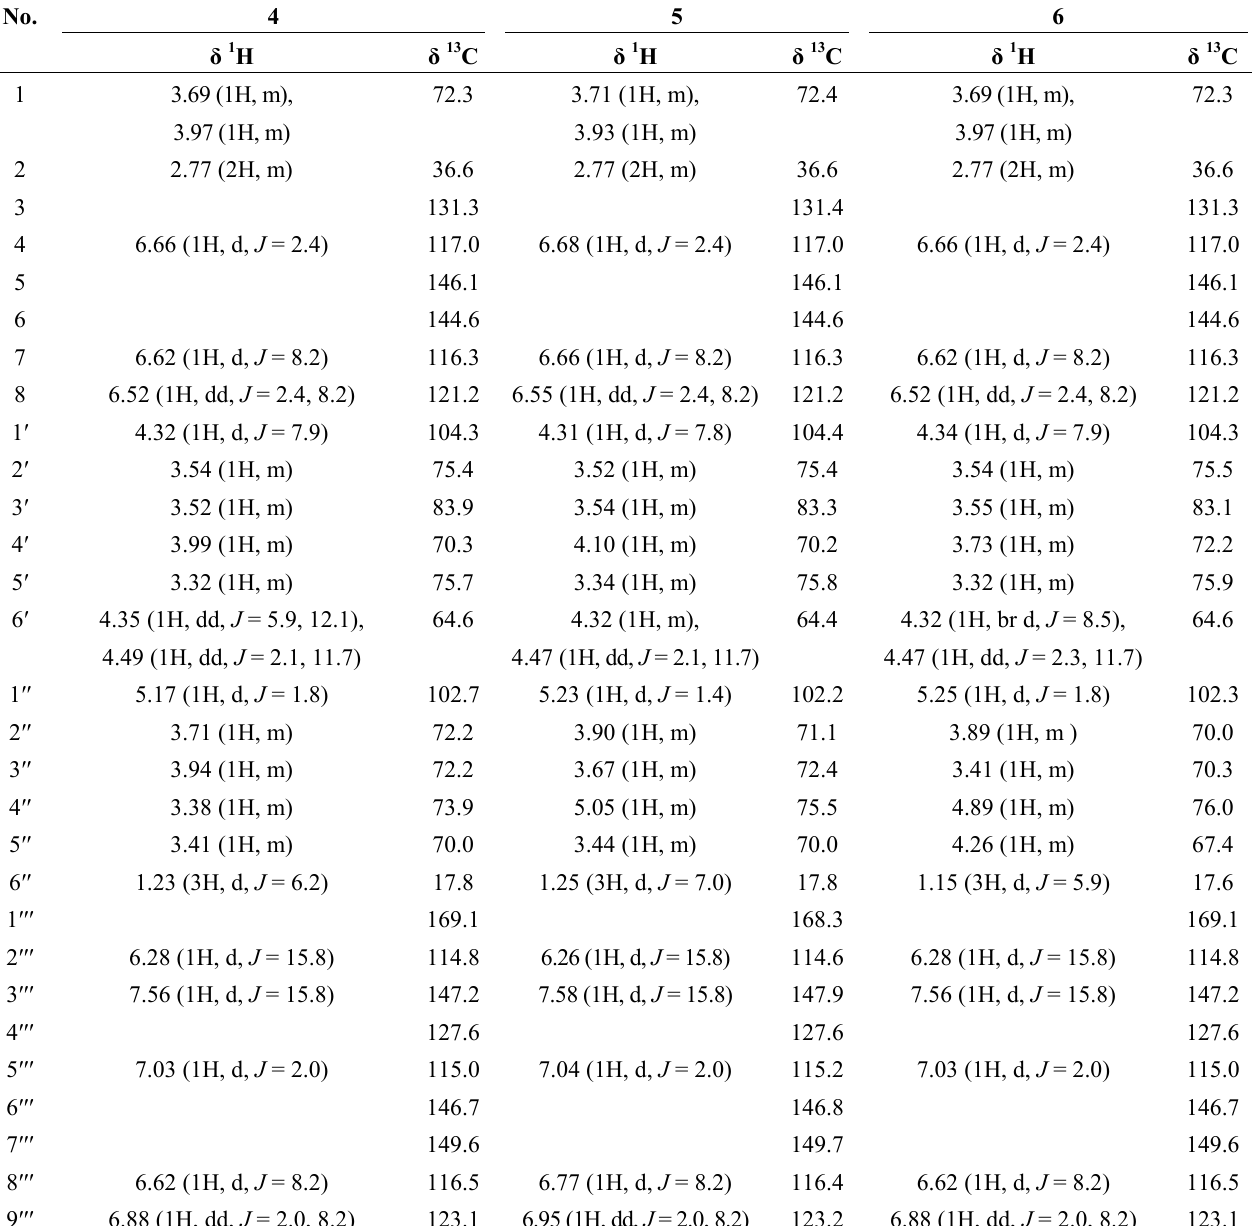
Table 2. 1 H-NMR and 13 C-NMR data for compounds 4 – 6 (CD